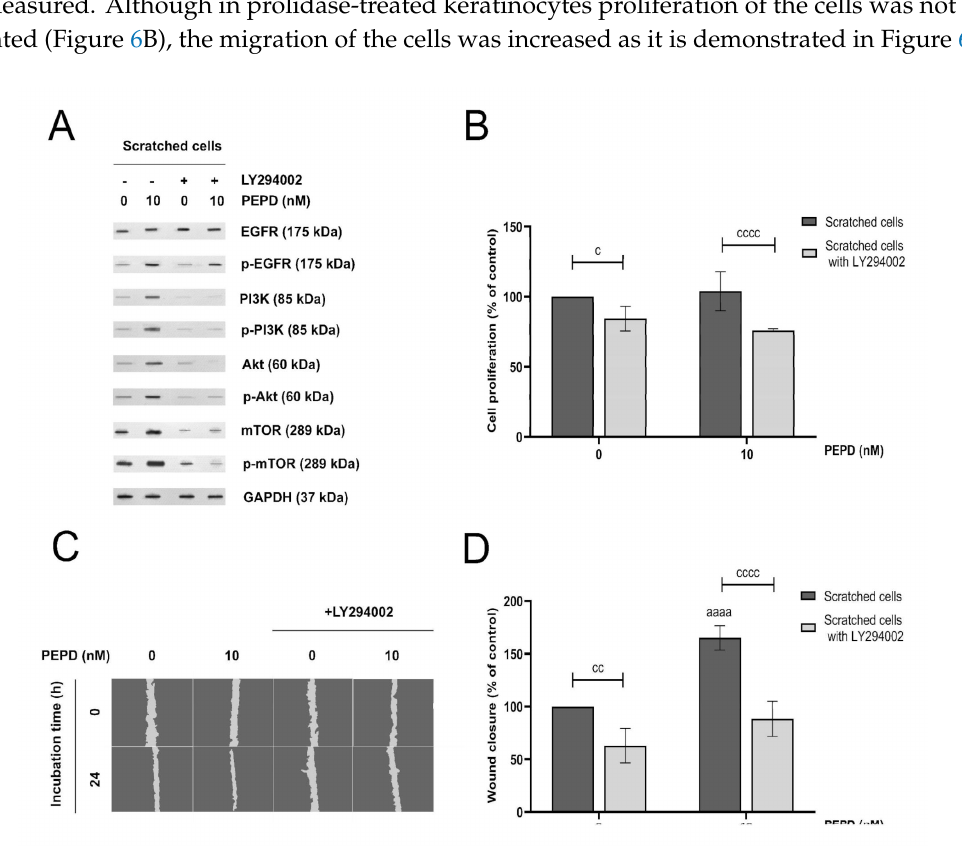
Figure 6. PI3K / Akt / mTOR signaling pathway is involved in prolidase-mediated proliferation and migration of HaCaT cells. ( A ) EGFR-downstream signaling pathway proteins analyzed by Western immunoblotting in lysates of scratched HaCaT cells incubated with prolidase (10 nM) and an inhibitor of PI3K (LY294002) for 30 min and 24 h. Representative blot images are shown (densitometric analysis of presented protein is included in Supplementary Materials (Supplementary Figure S6)). ( B ) Cell proliferation of scratched HaCaT cells incubated with prolidase and LY294002 for 24 h. ( C ) Prolidase- and LY294002-treated keratinocytes were scratched and monitored using an inverted microscope at 0 and 24 h of incubation. Supplementary Materials contain microscopic images in triplicates (Supplementary Figure S7). ( D ) Prolidase and LY294002-stimulated HaCaT cell migration was calculated using ImageJ software and presented as a percent of scratched control cells. A mean ± SEM of three replicates is presented. The results are significant at cc < 0.01, and aaaa , or cccc < 0.0001 and are marked as a vs. control (0 nM of PEPD) of scratched cells, b vs. control (0 nM of PEPD) of scratched cells pretreated with LY294002, and c marked scratched cells vs. scratched cells pretreated with LY294002 at the same concentration of PEPD,